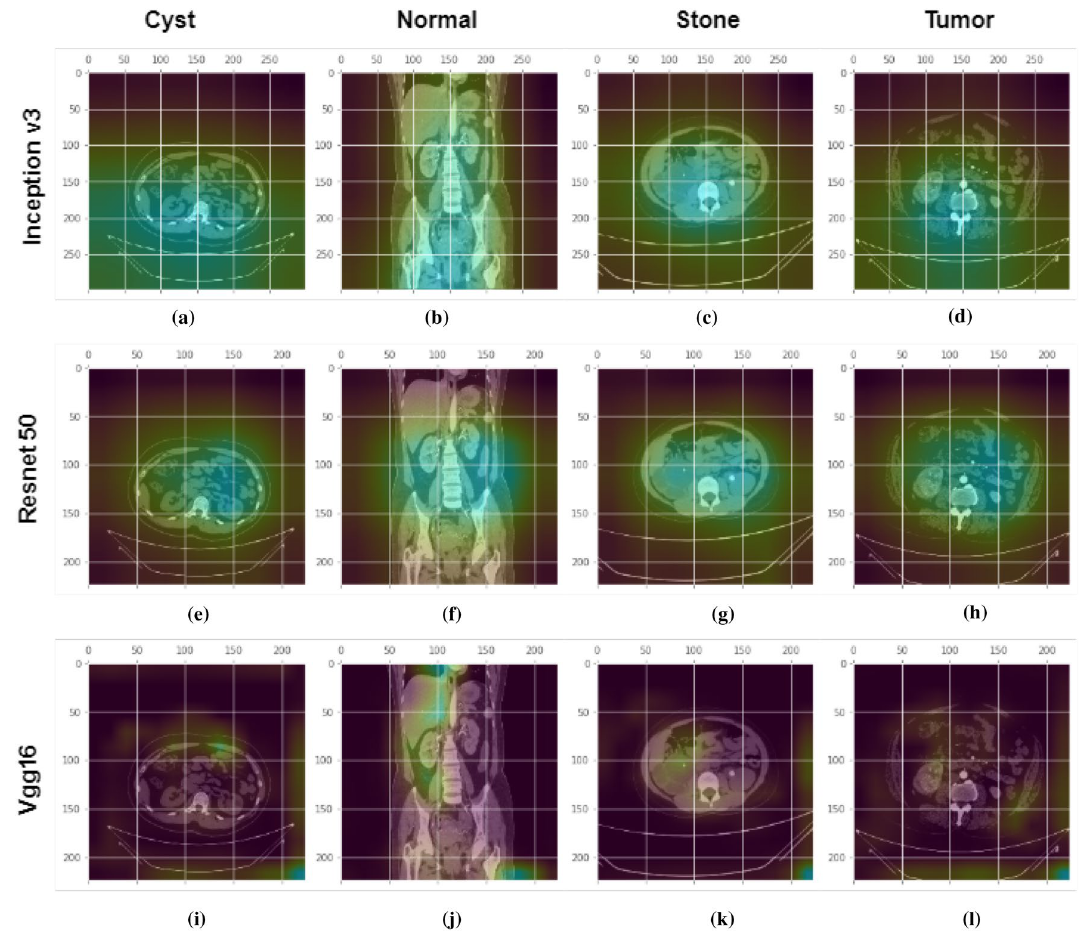
Figure 14. GradCam analysis of kidney Cyst, Normal, Stone and Tumor class photos at the final convolution layer in the Inception v3, Vgg16, and Resnet models. First row: shows the Gradcam images from inception v3 model for different classes. Second row: shows the Gradcam images from Resnet50 model for different classes. Third row: shows the Gradcam images from Vgg16 model for different classes. The GradCam activation mapping for the xray image is shown in the second row. The first, second, third, and fourth columns are for kidney cysts, normal, stone, and tumor classes